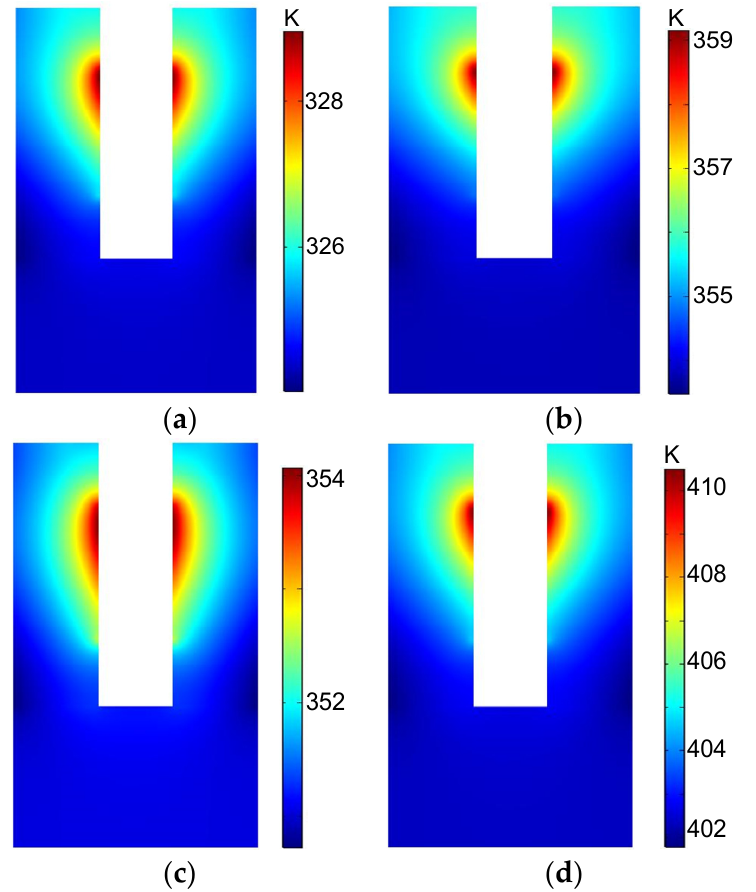
Figure 8. Temperature profile of the vertical MOSFET in the working state. ( a ) V DS = 3 V, V GS = 3 V, ( b ) V DS = 5 V, V GS = 3 V, ( c ) V DS = 3 V, V GS = 4 V, ( d ) V DS = 5 V, V GS = 4 V.